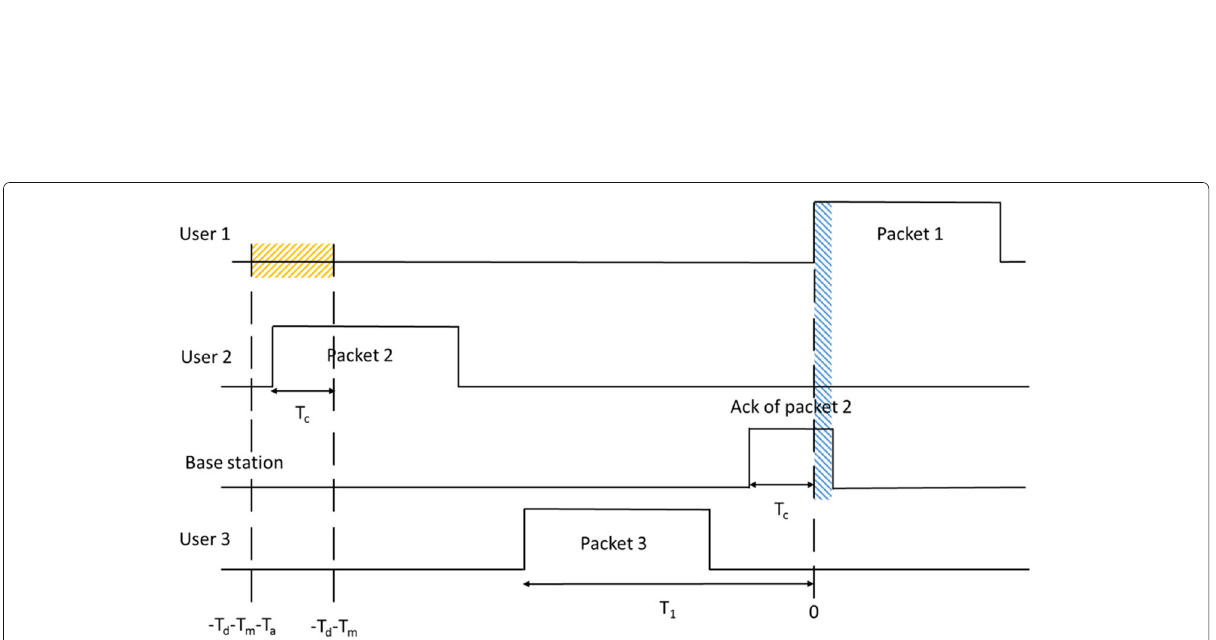
Fig. 9 T 1 is the interval between packet 1 and the packet sent just before it (packet 3), and T c is the interval between packet 1 and the transmission of the acknowledgement of packet 2 and the transmission of packet